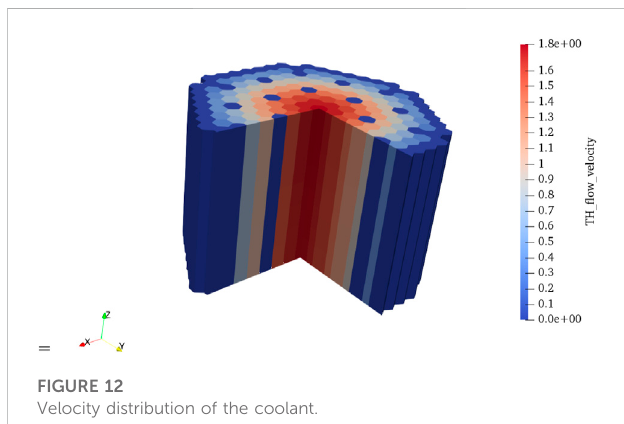
FIGURE 12 Velocity distribution of the coolant.